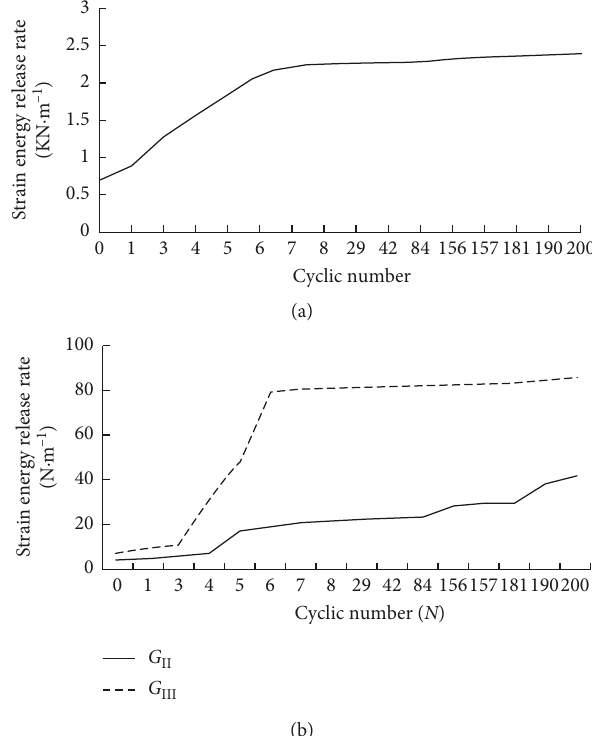
Figure 19: The cumulative strain energy release rate at the welding toe of top deck. (a) Opening fracture mode (Mode I crack). (b) Sliding and tearing fracture modes (Mode II and III cracks, respectively).